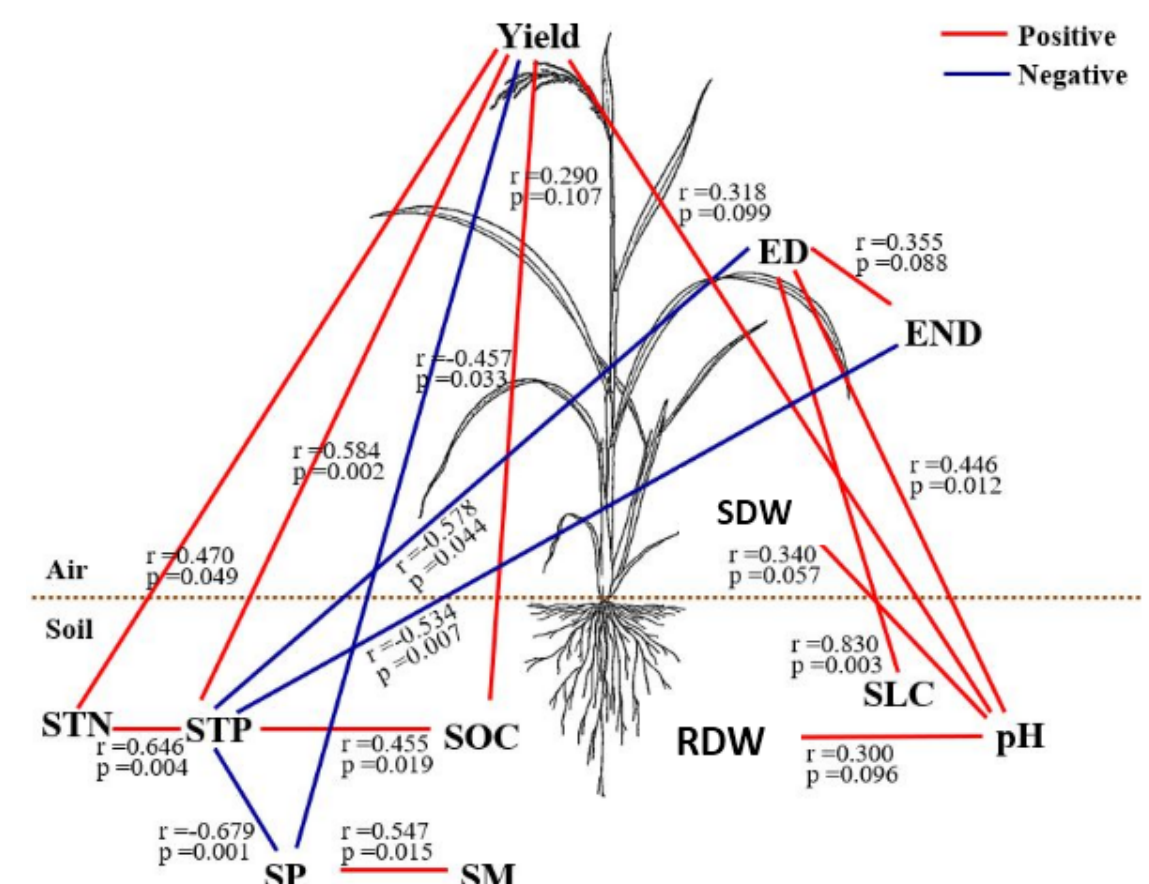
Figure 4: Opened up network of the BFBF